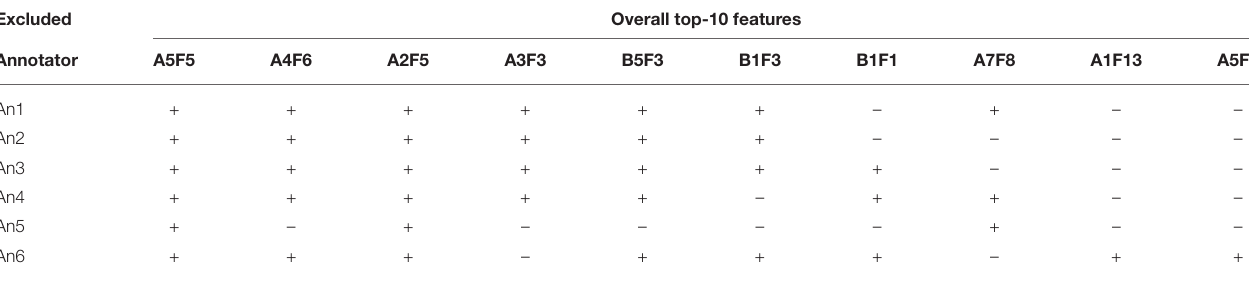
TABLE 6 | Most correlated features (questions) when one of the annotators is excluded: “+” if the feature remains among the top-10 correlated features, “–” if it gets removed.